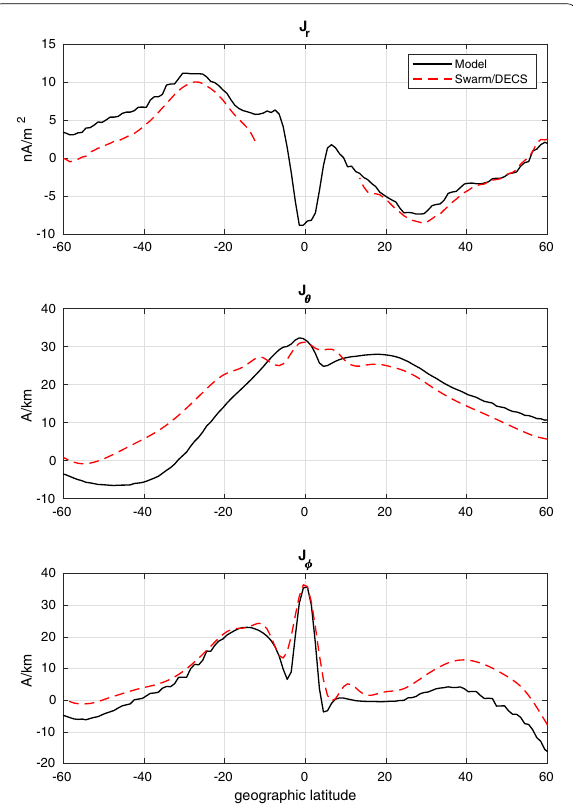
Fig. 3 Test T8. Latitude profiles of the the current components between the Swarm-A/C satellites. Black solid lines show the simulated current, while red dashed lines show the Swarm/DECS analysis result. In the top panel upward current is